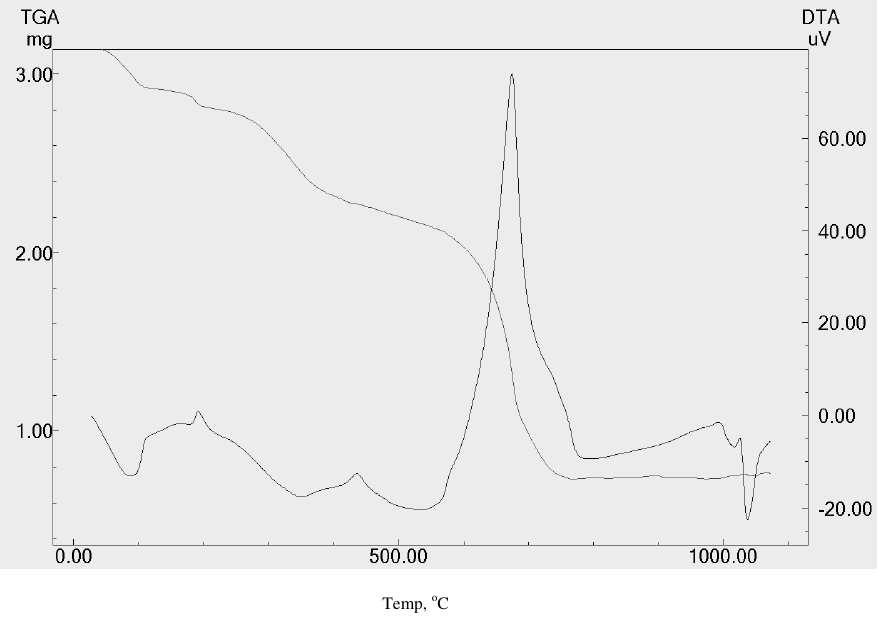
Figure 3. TG-DTA